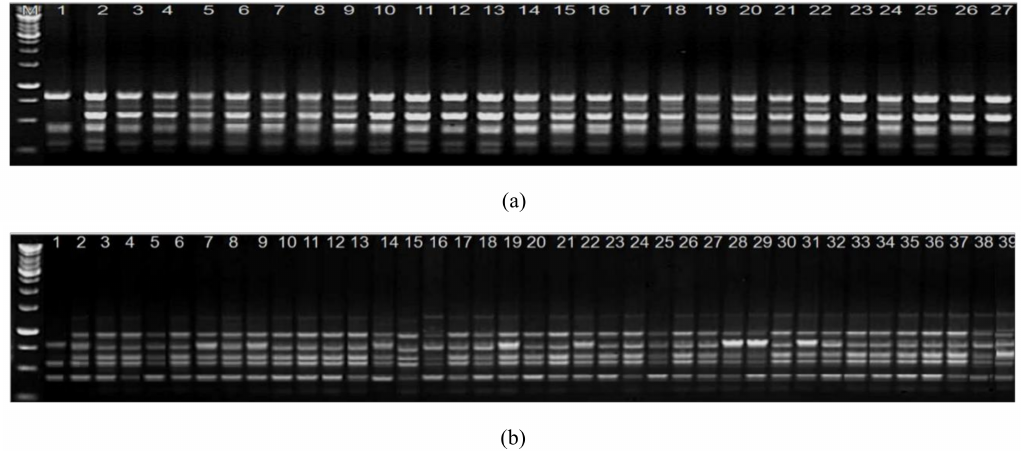
Figure 5. ( a ) Electrophoretic banding pattern of 1:JS335 and 2 to 27 selected putative drought tolerant plants amplified with Random Amplified Polymorphic DNA primer OPN-13. ( b ) Electrophoretic banding pattern of 1:JS93-05 and 2 t0 39 selected putative drought tolerant plants amplified with RAPD primer